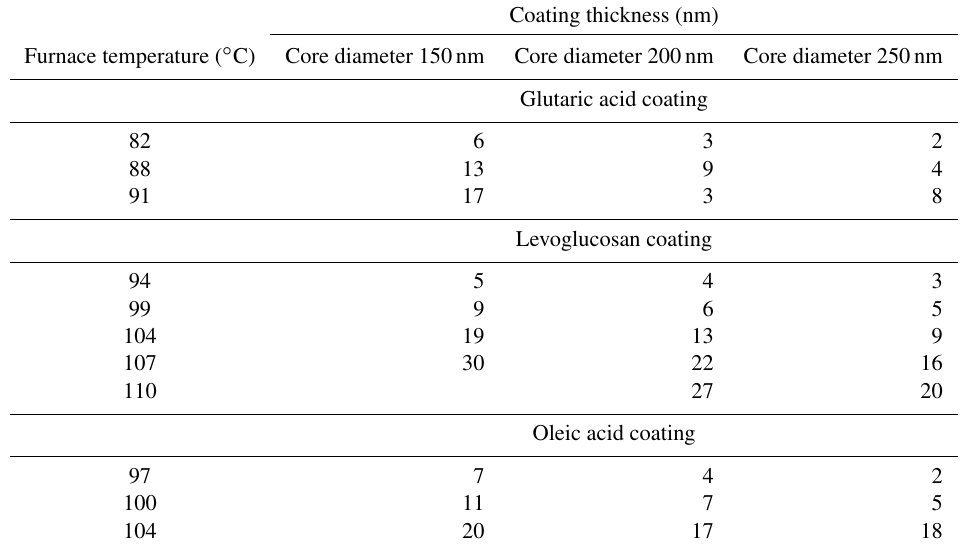
Table 2. Coating thicknesses of organic species on the BC cores at different temperatures of the coating